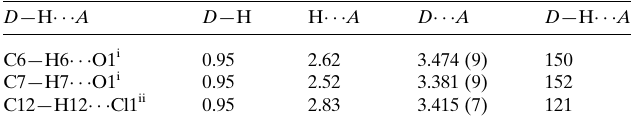
Table 3 Hydrogen-bond geometry (A˚ , (cid:4) ) for (III).